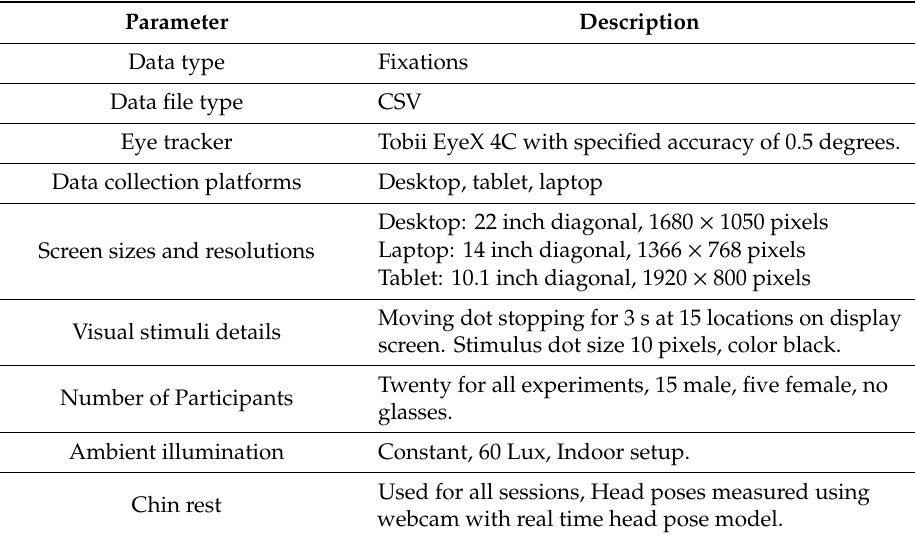
Table 4. Features of the gaze data collection process for building the NUIG_EyeGaze01